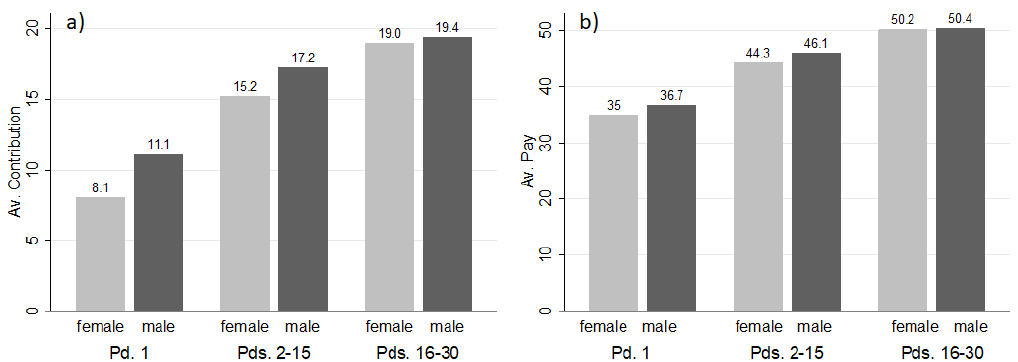
Figure 3. Average contributions (panel a ) and pay (panel b ) of women (grey bars) and men (black bars) over different periods. The first pair of bars shows the averages in the first period. The second pair of bars shows the averages over periods 2–15, and the third pair of bars shows the averages over periods 16–30.